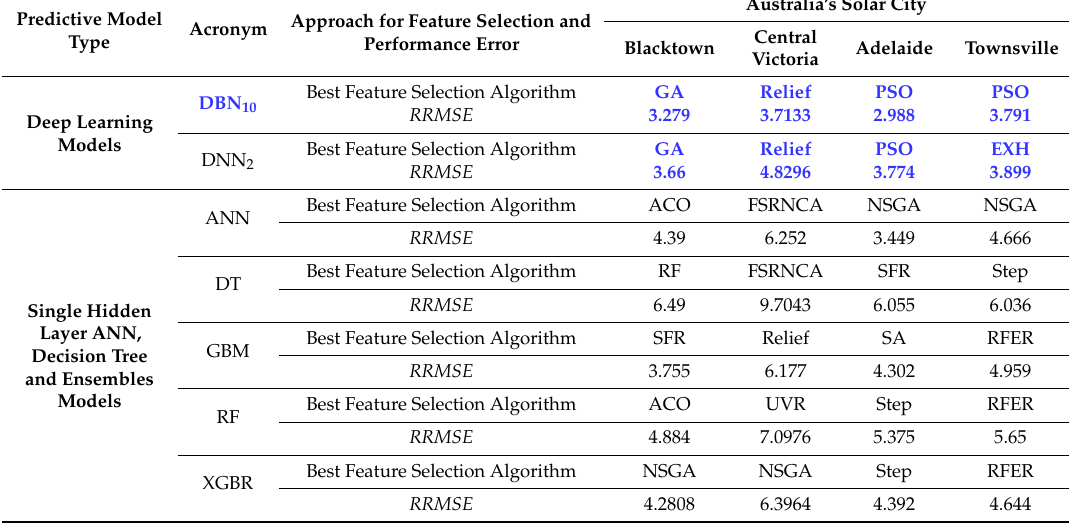
Table 6. Evaluating the training performance of DBN 10 and DNN 2 vs . the counterpart models in terms of their best feature selection methods, as measured by the relative root mean squared error ( RRMSE , %) used for long-term GSR